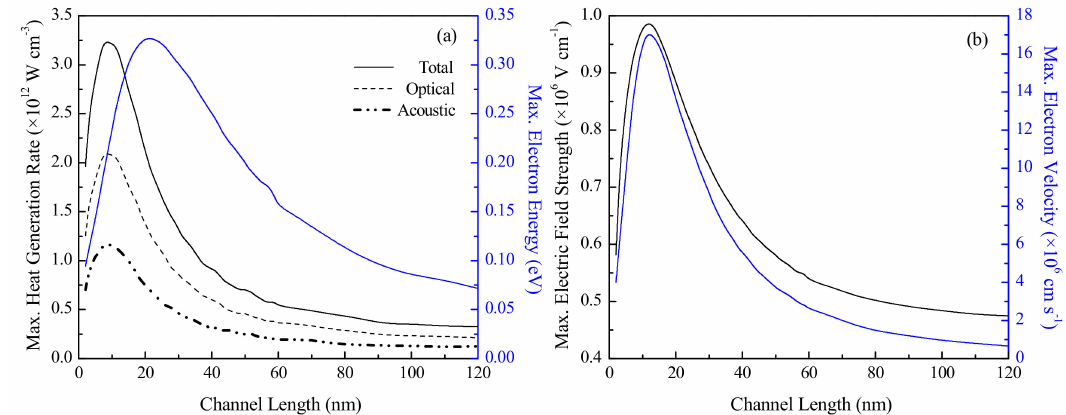
Figure 6. Variation of the maximum ( a ) heat generation rate and electron energy and ( b ) electric field strength and electron drift velocity in an n + nn + device with channel length at 300 K. In ( a ), the separate contributions of the optical and acoustic phonon modes to the total heat generation rate are also